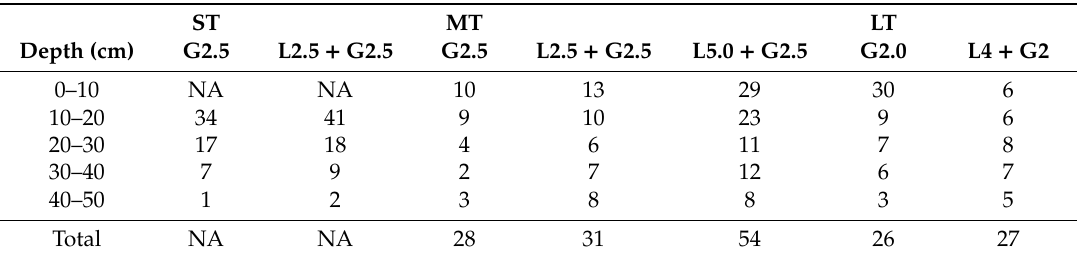
Table 1. Recovery (%) of the applied SO 4 -S as calculated by the di ff erence in S KCl C treatments for the short-term (ST), medium-term (MT) and long-term (LT) experiments using soil samples collected in March